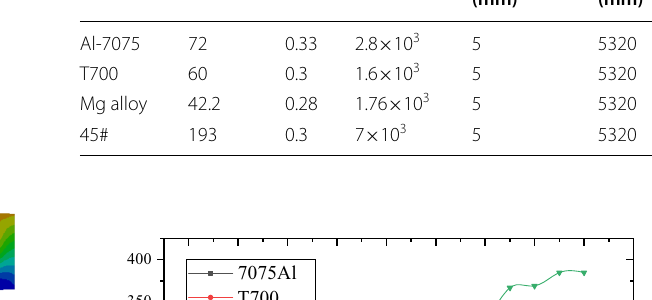
Figure 11 Displacement cloud diagram under two conditions (B/D)